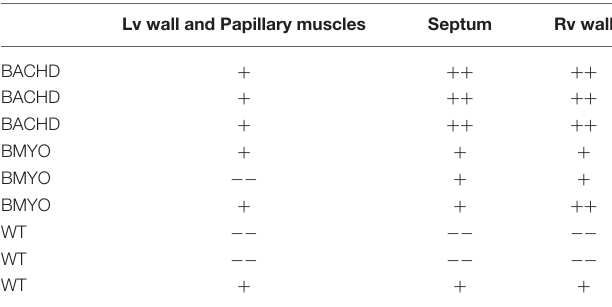
TABLE 3 | Masson’s Trichrome staining was used to investigate the presence of fibrotic tissue in heart sections from WT, BACHD and BMYO mice at 6 months of age.